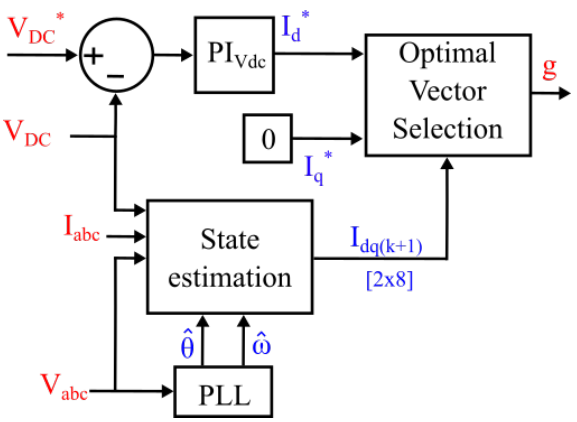
Figure 28. OSV-MPC with PLL in a synchronous reference